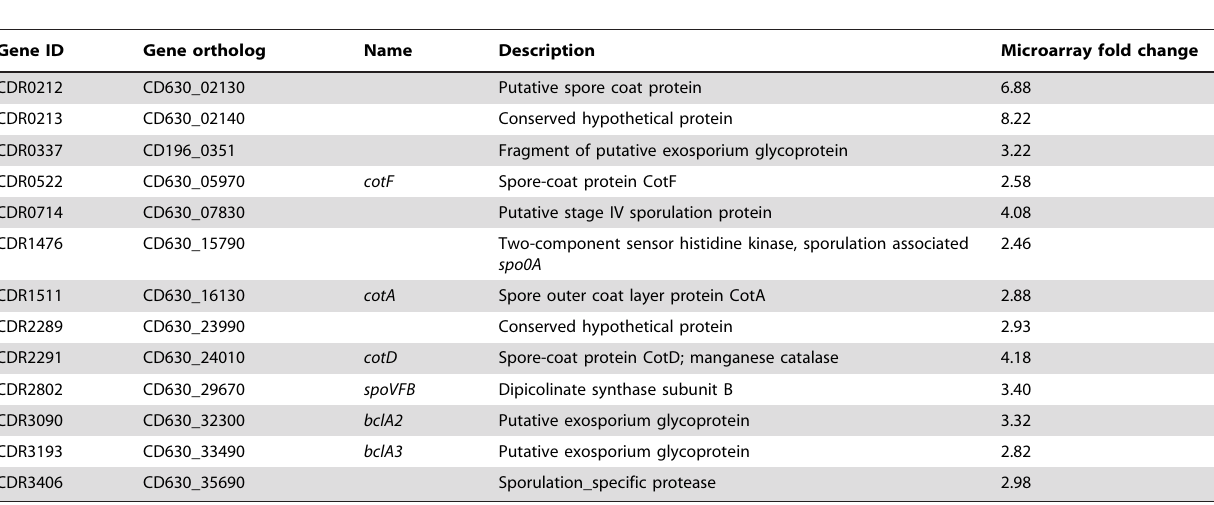
Table 3. Sporulation genes highly differentially expressed in vivo in the fliC mutant compared to strain R20291.